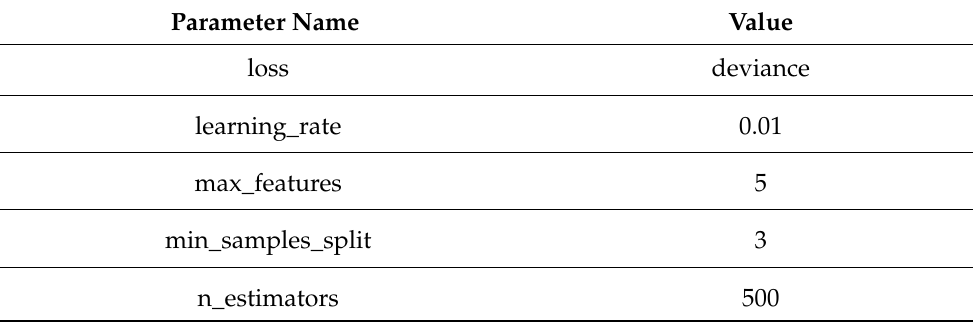
Table 7. Tuned gradient boosting